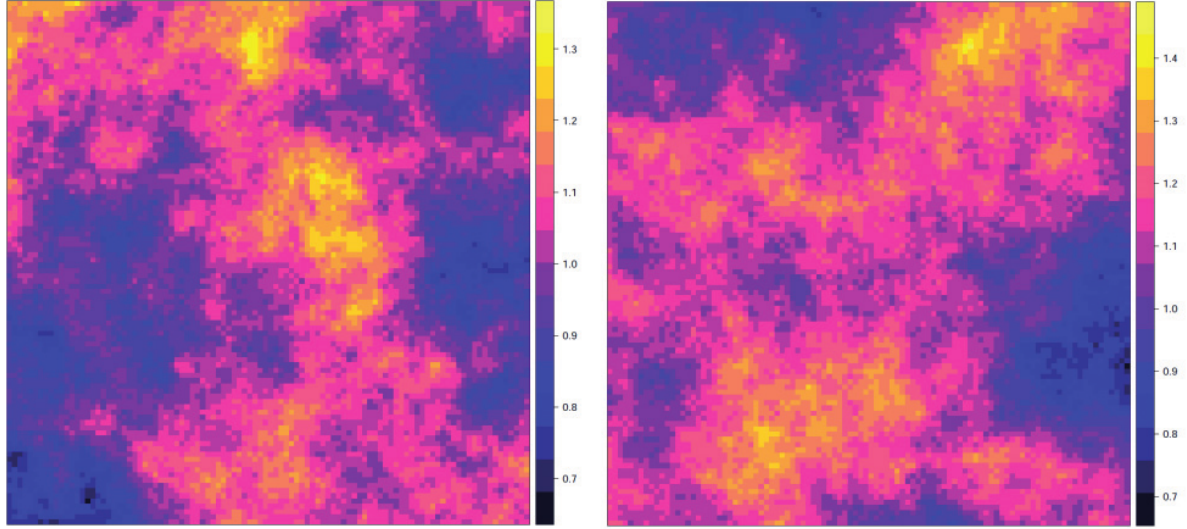
Figure 1. Simulated spatial distributions of hazard (left) and exposure (right) over a common area frame, gemerated by stochastic realiza- tion of Gaussian Random Fields.